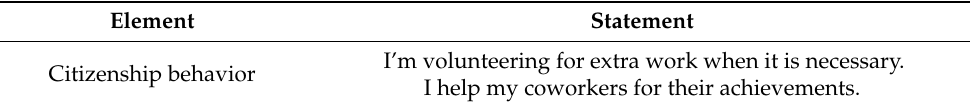
Table 4. Elements and statements of the dimension called citizenship